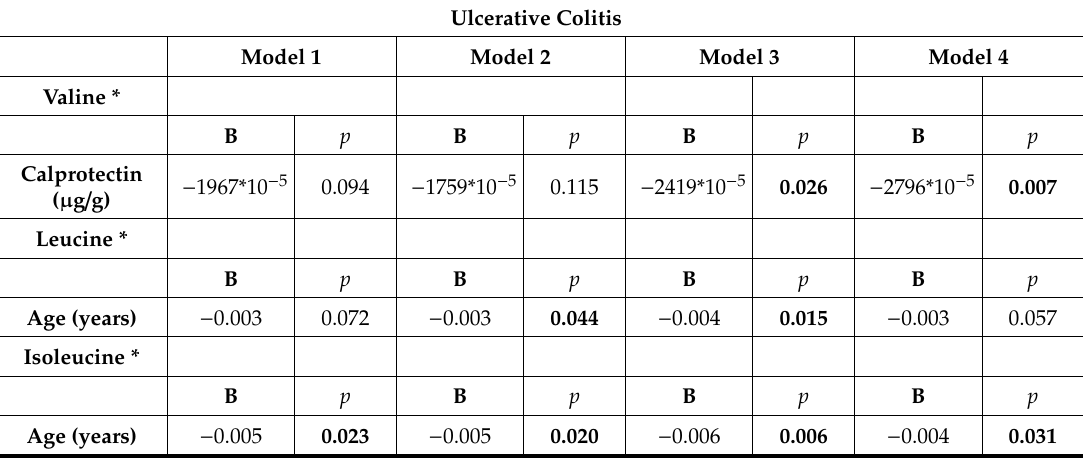
Table 4. Multivariate regression analysis addressing the associations between BCAAs with patient